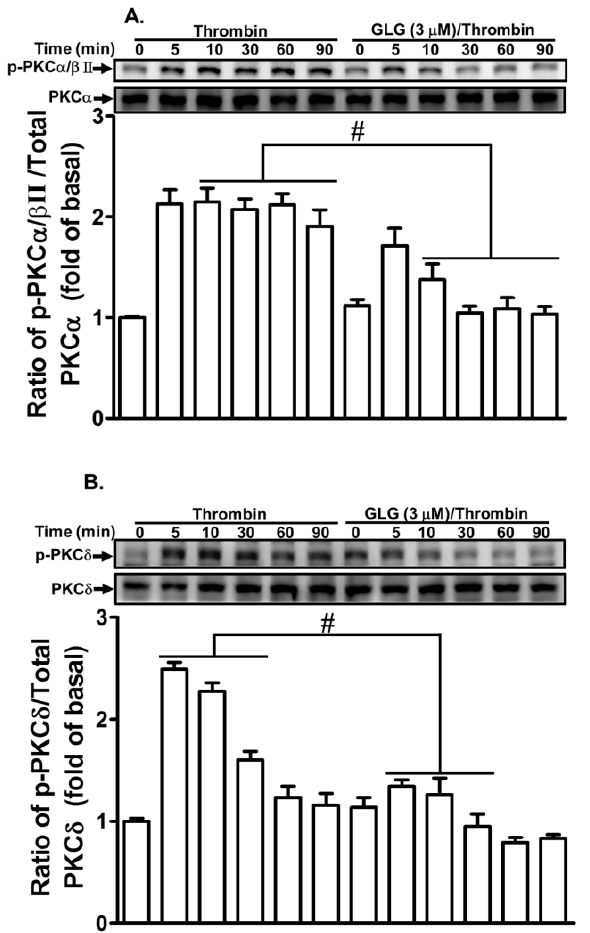
Figure 3. Galangin inhibits thrombin-induced phosphorylation of protein kinase C (PKC) α / β II and δ . The cells were pretreated with galangin (3 μ M) for 1 h and then incubated with thrombin (10 U/mL) for the indicated time intervals. The levels of ( A ) PKC α / β II and ( B ) PKC δ phosphorylation and their respective protein levels were determined by western blot. The data are expressed as mean ± SEM of three independent experiments. * p < 0.05; # p < 0.01, as compared with the cells exposed to thrombin alone.